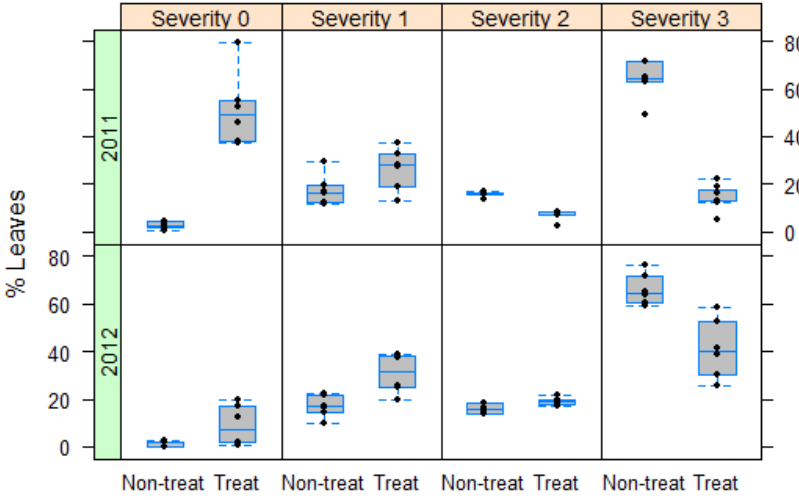
Figure 3. Box-whisker plots of the percentages of leaves in the categories of greasy spot severity observed in trees treated with fenbuconazole and the non-treated control in experiment 2 on ’Valencia’ sweet orange at Miraflores, Panama, in 2011 and 2012 (0 = no lesions; 1 = 1–10 leaf spots; 2 = 11–20 leaf spots; 3 = more than 20 leaf spots). Three sprays of fenbuconazole were applied in 2011 and one spray in